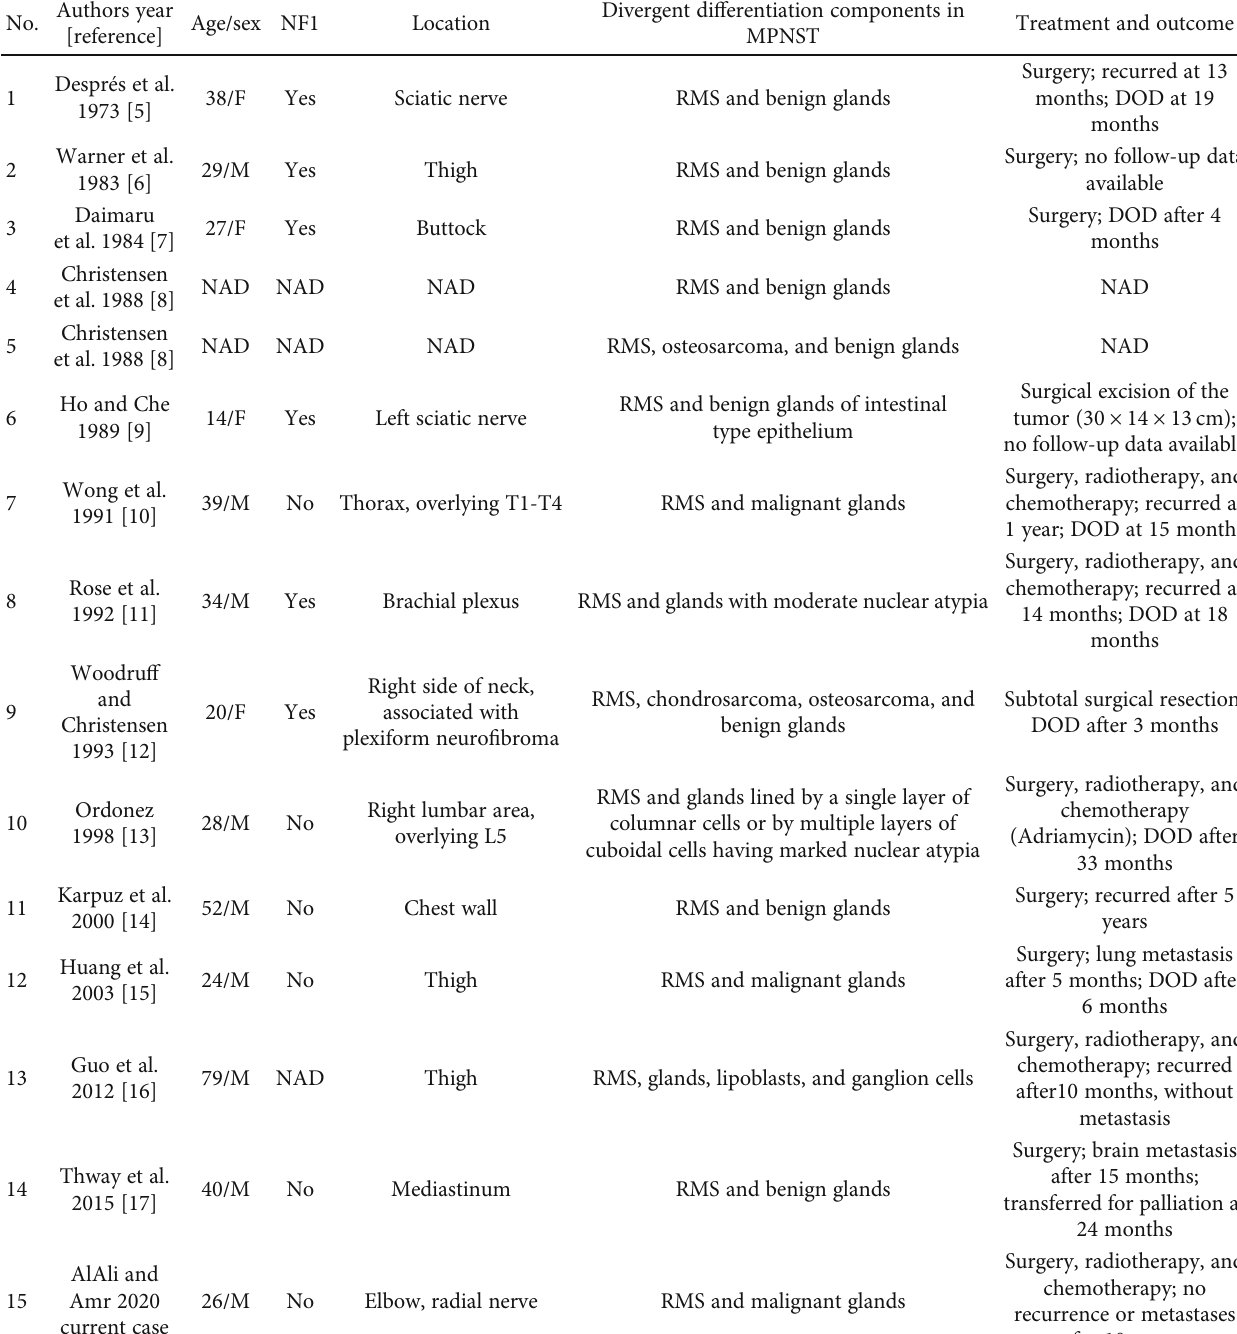
Table 1: Reported cases of triton tumor with glandular di ff